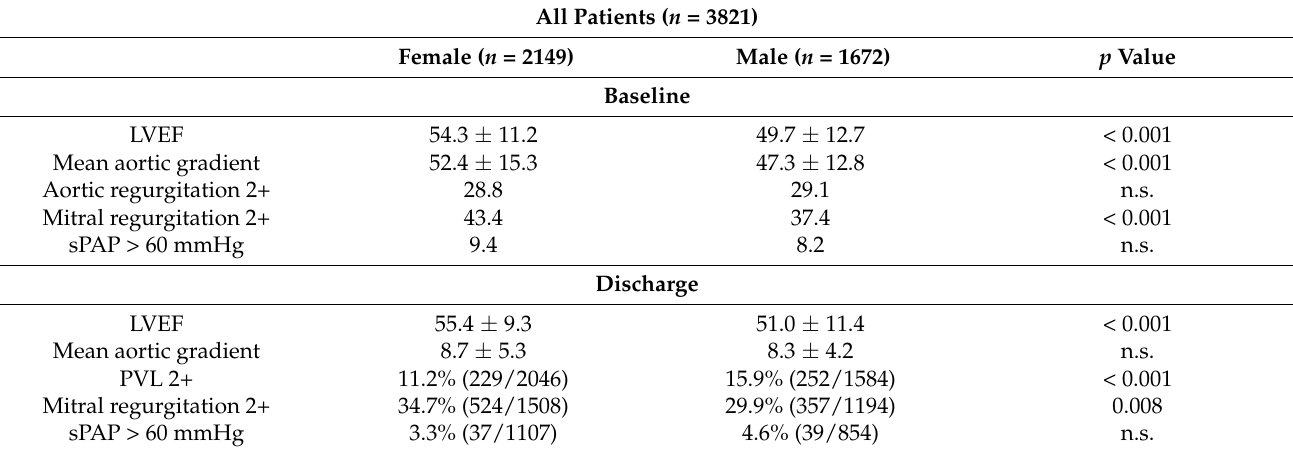
Table 3. Echocardiographic parameters after